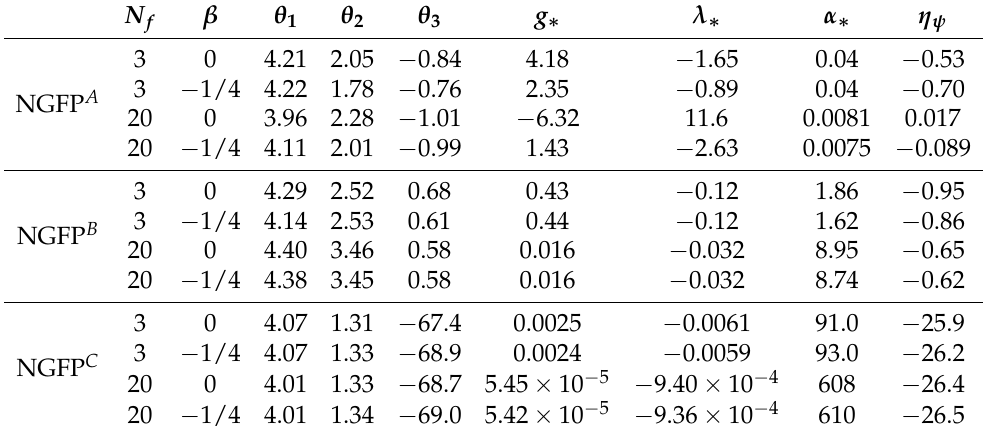
Table 3. Examples illustrating the generic properties associated with the three families of fixed points for selected values N f and β . The NGFP’s of Family A and C constitute saddle points for the RG flow while NGFP B act as UV-attractors for the RG flow in the g - λ - α − hyperplane. In contrast to the Reuter fixed point (41), all examples come with real stability coefficients.